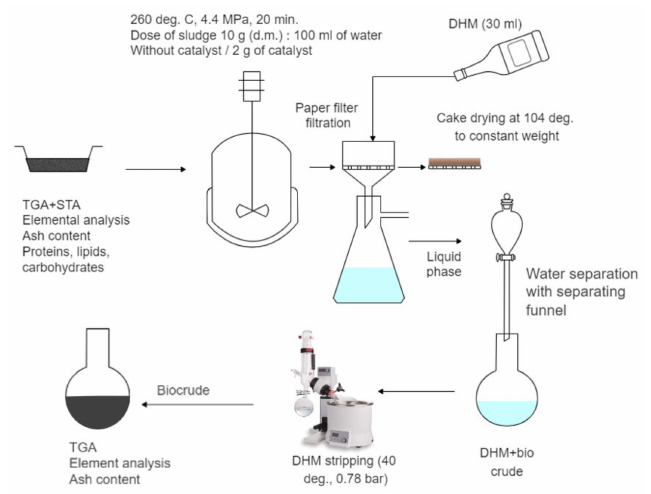
Figure 1. Research